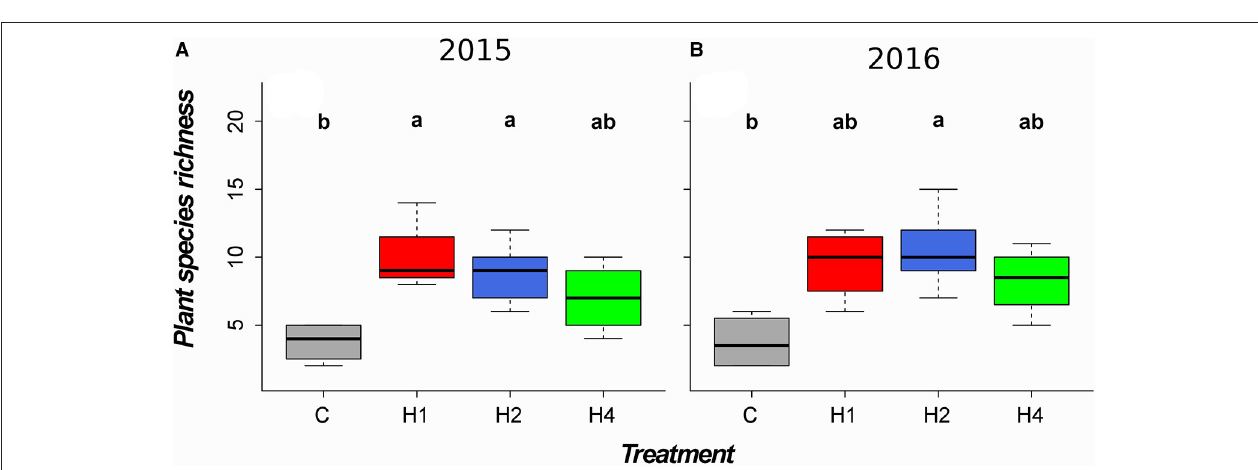
FIGURE 2 | Boxplots of plant species richness for the second and third experimental year for the tall herb fringe community. Horizontal lines indicate the median, boxes the interquartile range and whiskers the 95% interval of the data. Panel and treatment designation as in Figure 1 . Different letters indicate significant difference ( p < 0.05) tested by linear mixed effects model with post-hoc test for pairwise comparisons (for details, see Appendix Table 4 in Supplementary Material). Community-weighted medians (min, max) after the first experimental year (non-significant, LMEM, see Appendix Table 5 in Supplementary Material) as well as boxplots for the other tested community types (non-significant, LMEM) can be found in Appendix Image 3 (Supplementary Material). (A) 2015, (B)